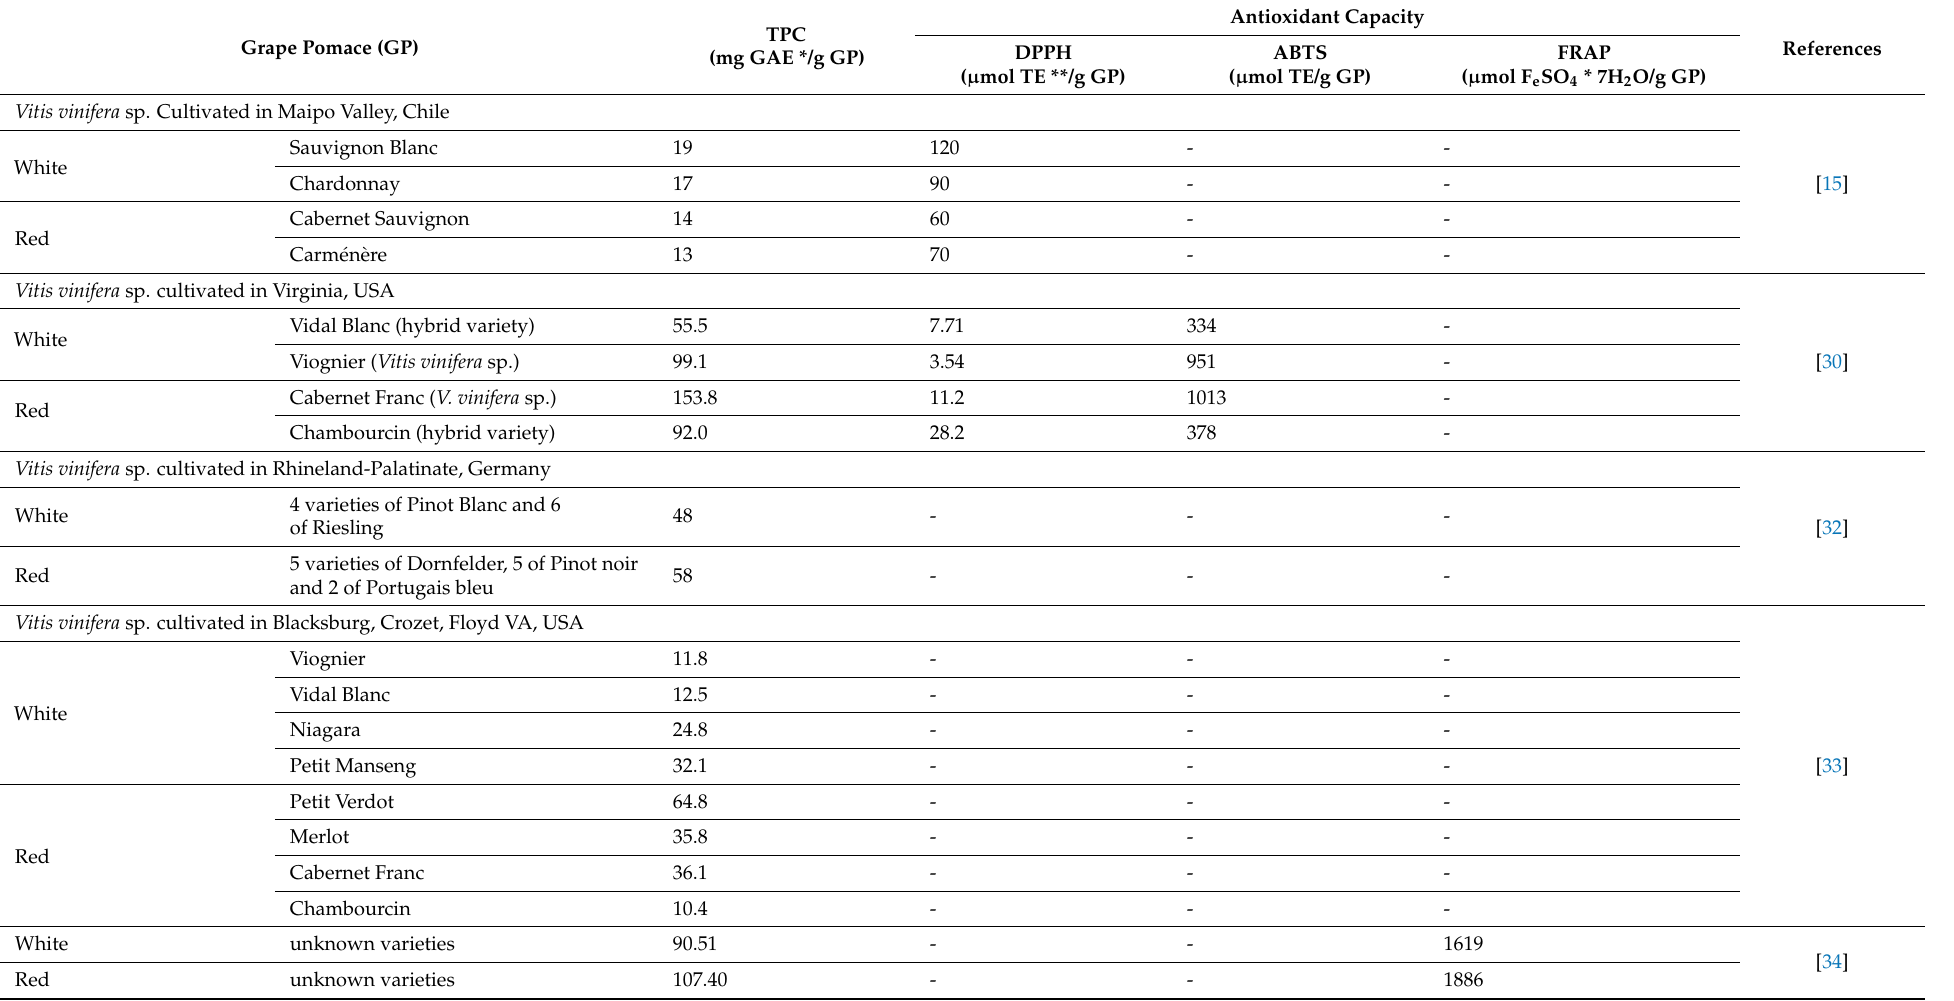
Table 1. Comparison of total polyphenols content (TPC) and antioxidant capacity of red and white grape pomace polyphenols